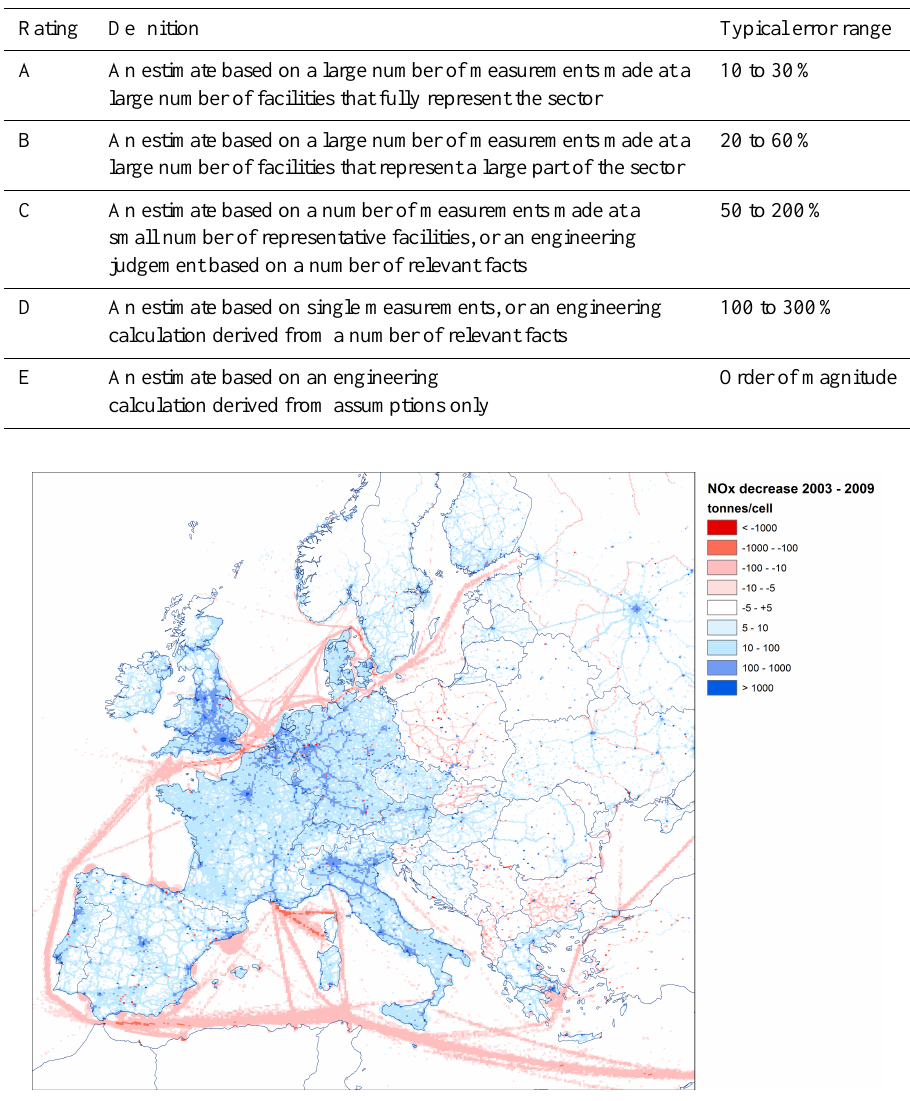
Figure 10. Change in NO x emissions between 2003 and 2009 in Europe, for all